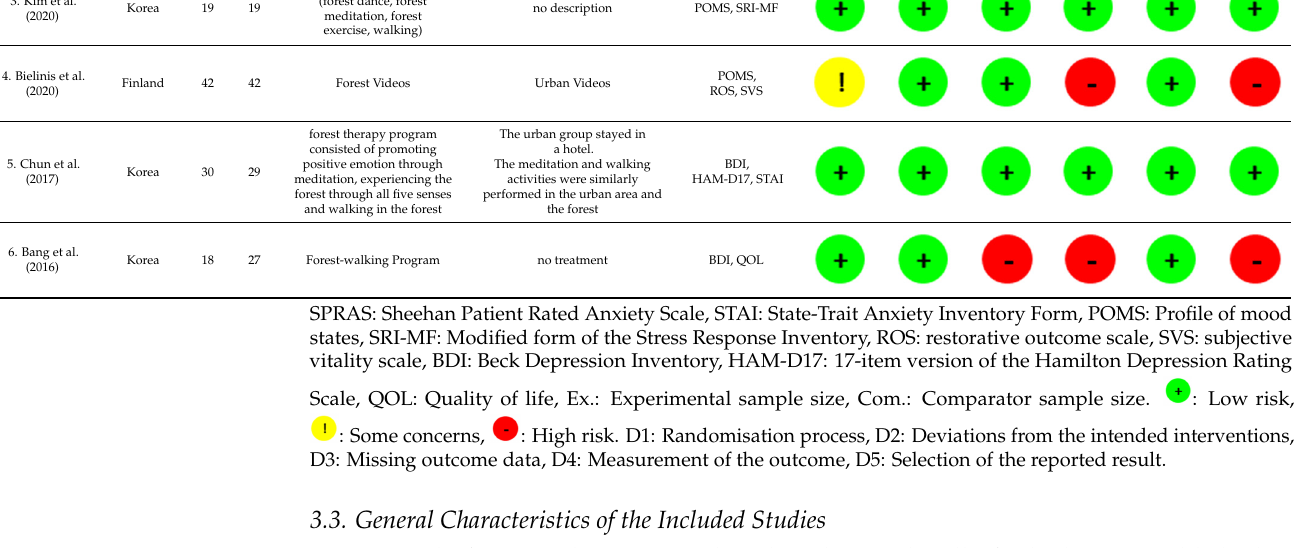
BDI, QOL SPRAS: Sheehan Patient Rated Anxiety Scale, STAI: State-Trait Anxiety Inventory Form, POMS: Profile of mood states, SRI-MF: Modified form of the Stress Response Inventory, ROS: restorative outcome scale, SVS: subjective vitality scale, BDI: Beck Depression Inventory, HAM-D17: 17-item version of the Hamilton Depression Rating Scale, QOL: Quality of life, Ex.: Experimental sample size, Com. : Comparator sample size. : Low risk, : Some concerns, : High risk. D1: Ran- domisation process, D2: Deviations from the intended interventions, D3: Missing outcome data, D4: Measurement of the outcome, D5: Selection of the reported result. 3.4. Outcome Variables and the Effect Sizes of Forest Therapy Intervention Studies In this study, we analyzed a total of 34 outcome variables from 6 studies. The overall effect size of the forest therapy programs was 1.25 (95% CI = 0.93–1.57, p < 0.001), which was large and statistically significant (Figure 2). Heterogeneity was high (I 2 = 90.0%). The results of the analysis of the effect variables were classified into four subgroups (depres- sion, anxiety, positive emotions, and negative emotions). 3.4.1. Depression